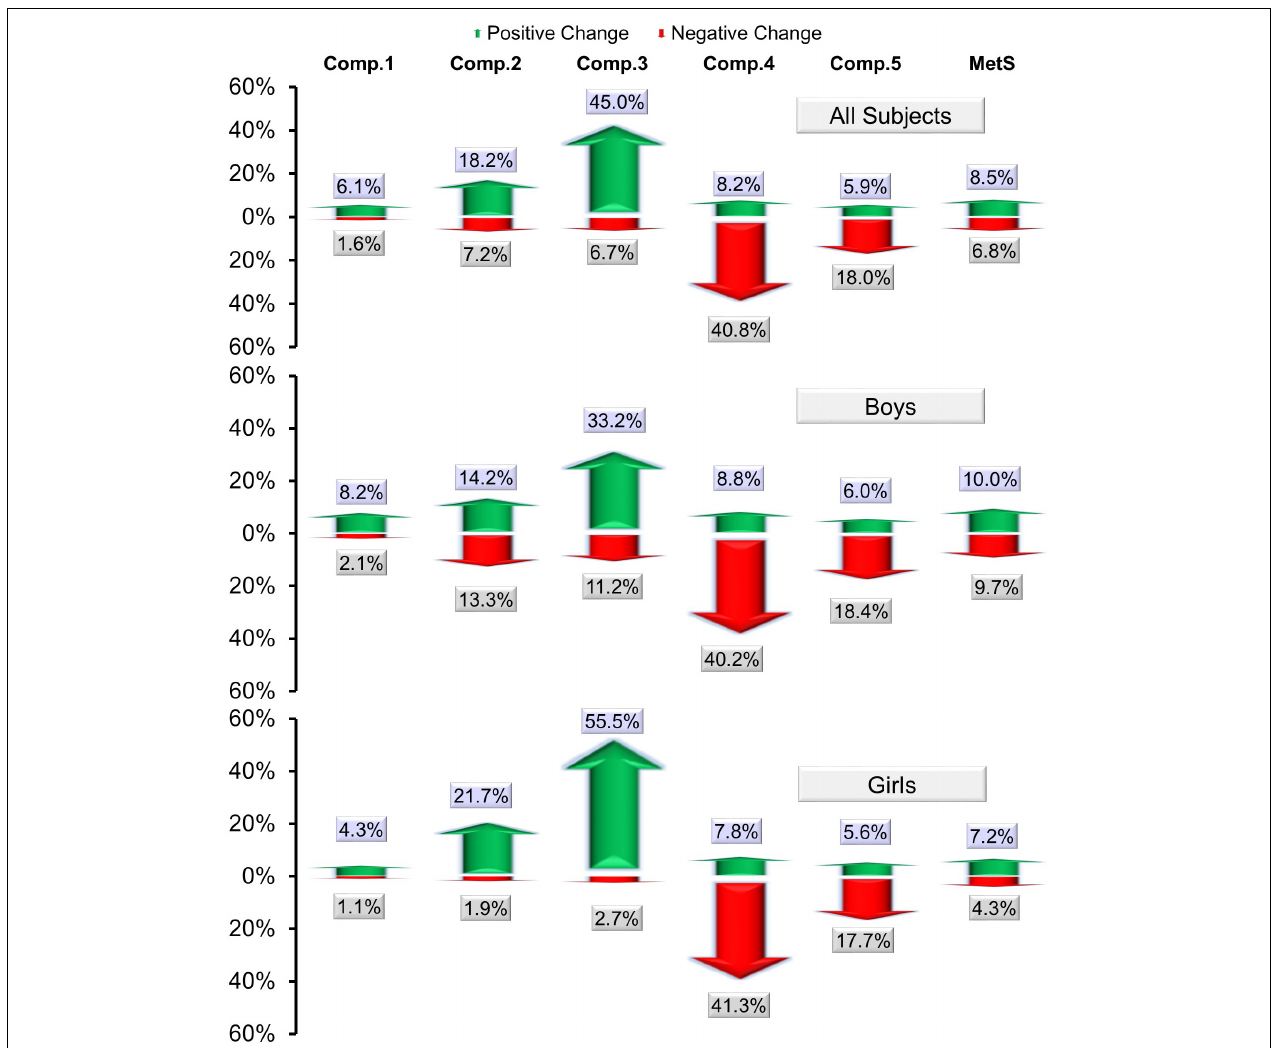
FIGURE 2 | A bar graph showing the percentages of positive change (from “yes” at baseline to “no” post-intervention) and negative change (from “no” at baseline to “yes” post-intervention) in MetS and its components. Here, comp. 1, 2, 3, 4, and 5 represent “central obesity,” “hypertension,” “low-HDL cholesterol,” “hypertriglyceridemia,” and “hyperglycemia,”